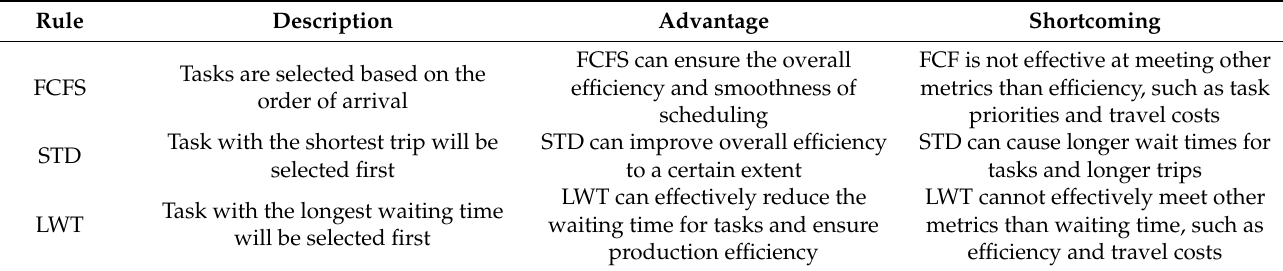
Table 1. Scheduling